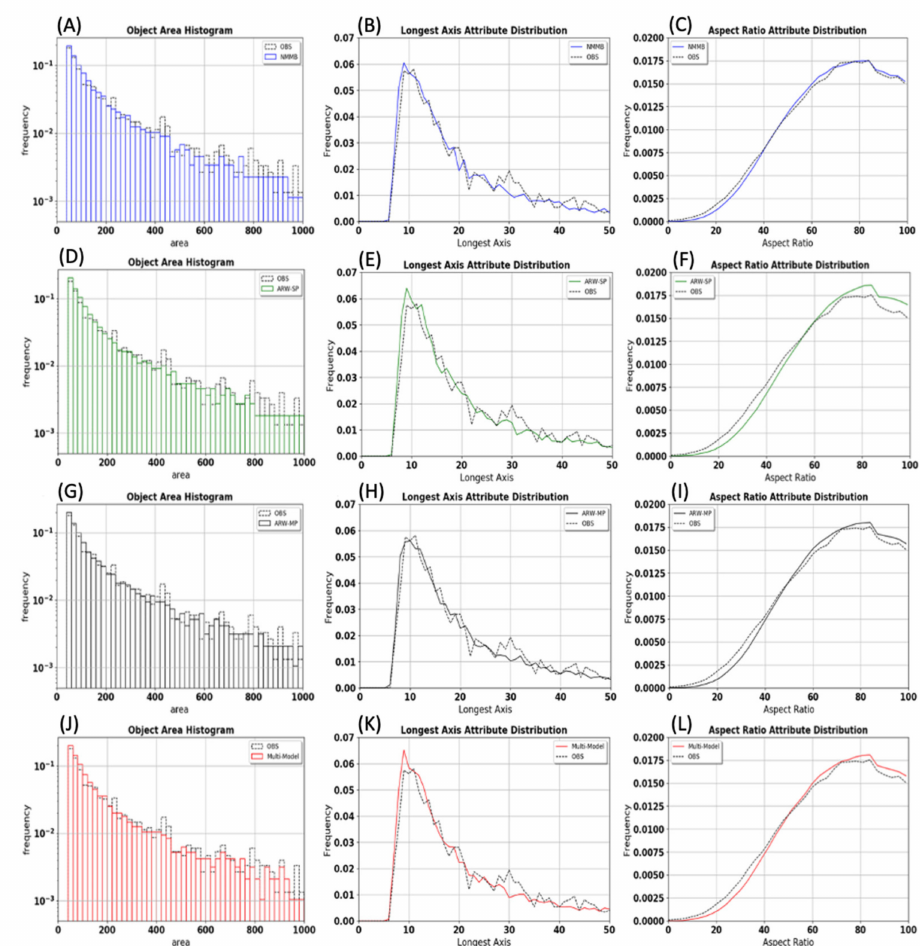
Figure 5. Normalized ensemble object attribute distributions for each ensemble (rows). Left column: Ensemble object area frequency distribution (solid) and observations (black, dashed) binned every 20 gpts. Center column: Ensemble object longest axis frequency distribution rounded to the nearest grid point (solid) and observations (black, dashed). Right column: Ensemble object aspect ratio distribution where each plotted point is averaged with +/ − 2 nearest points. Panels show frequency of objects of different areas for ( A ) NMMB, ( D ) ARW-SP, ( G ) ARW-MP, and ( J ) MM; frequency of objects of different long axis length for ( B ) NMMB, ( E ) ARW-SP, ( H ) ARW-MP, and ( K ) MM; frequency of objects of different aspect ratios for ( C ) NMMB, ( F ) ARW-SP, ( I ) ARW-MP, and ( L )